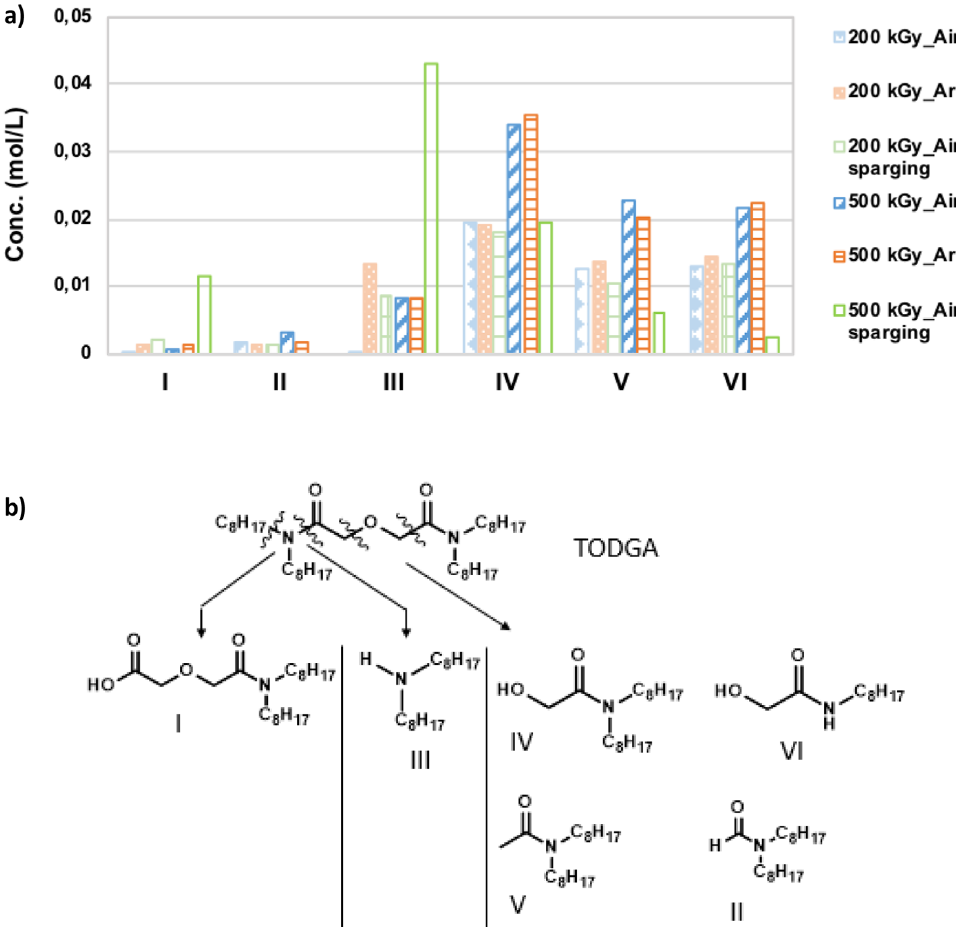
Fig. 6. (a) HPLC-MS quantitative studies of different TODGA degradation compounds at different experimental conditions: air, Argon, air sparging for 0.2mol/L TODGA in OK irradiated in contact with 0.5 mol/L HNO 3 . (b) Structure of TODGA and its radiolytic pathway to produce DCs I, III, IV, V and